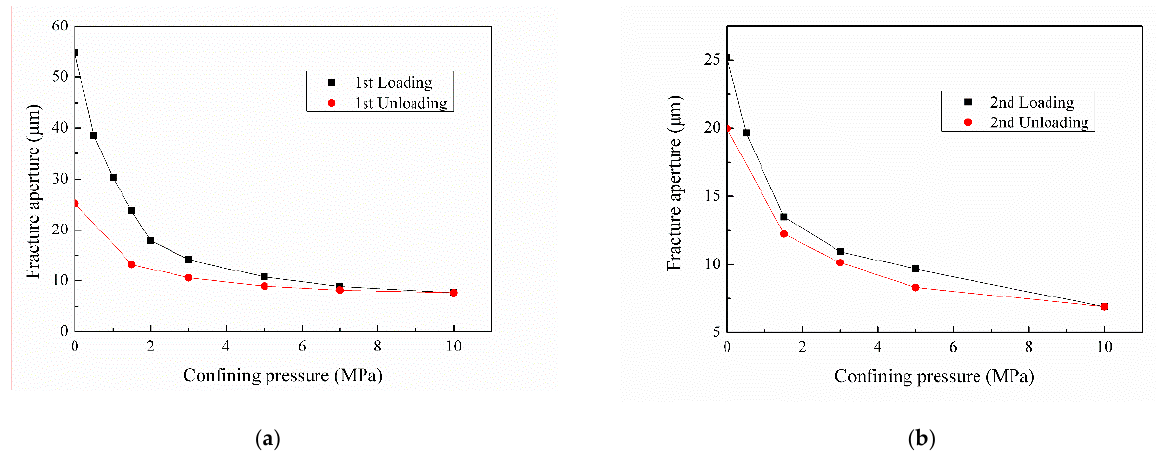
Figure 10. The measurement results of fracture aperture: ( a ) the first cycle, ( b ) the second cycle.